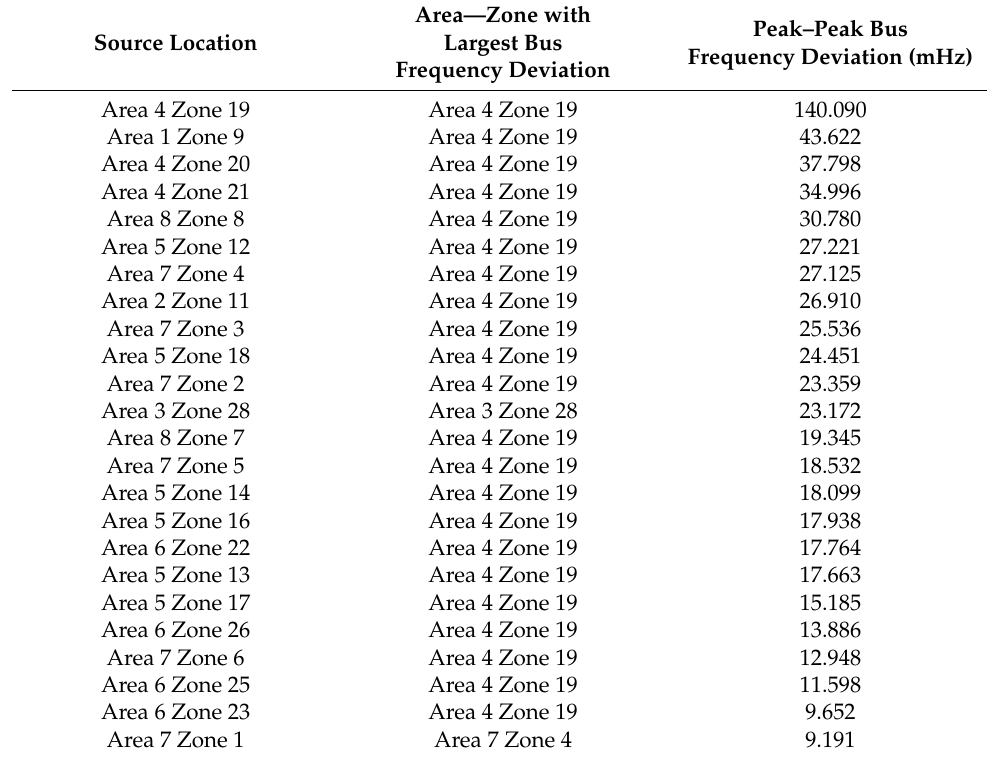
Table 3. Location dimension scanning results when the critical forced oscillation frequency is 0.67 Hz.